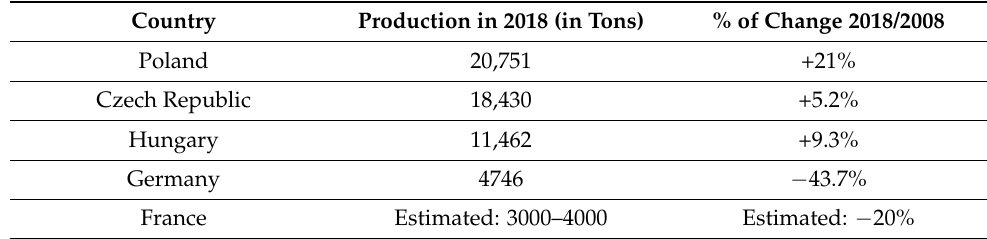
Table 4. Production of common carp in the UE in